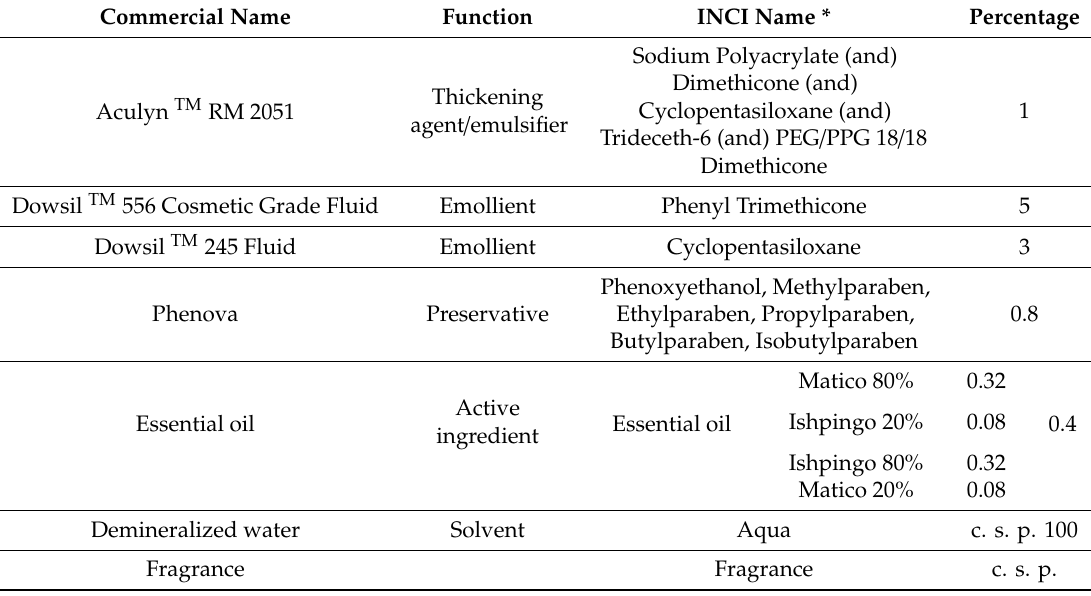
Table 2. Cosmetic formulation of the lotion based on Aristeguietia glutinosa ( matico ) and Ocotea quixos ( ishpingo